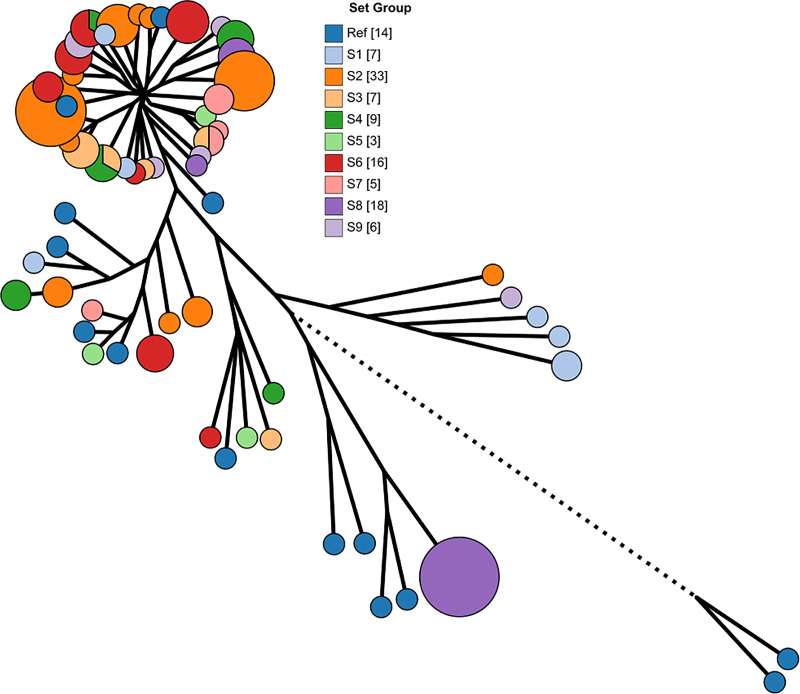
Phylogenetic tree with nodes coloured by sample set.